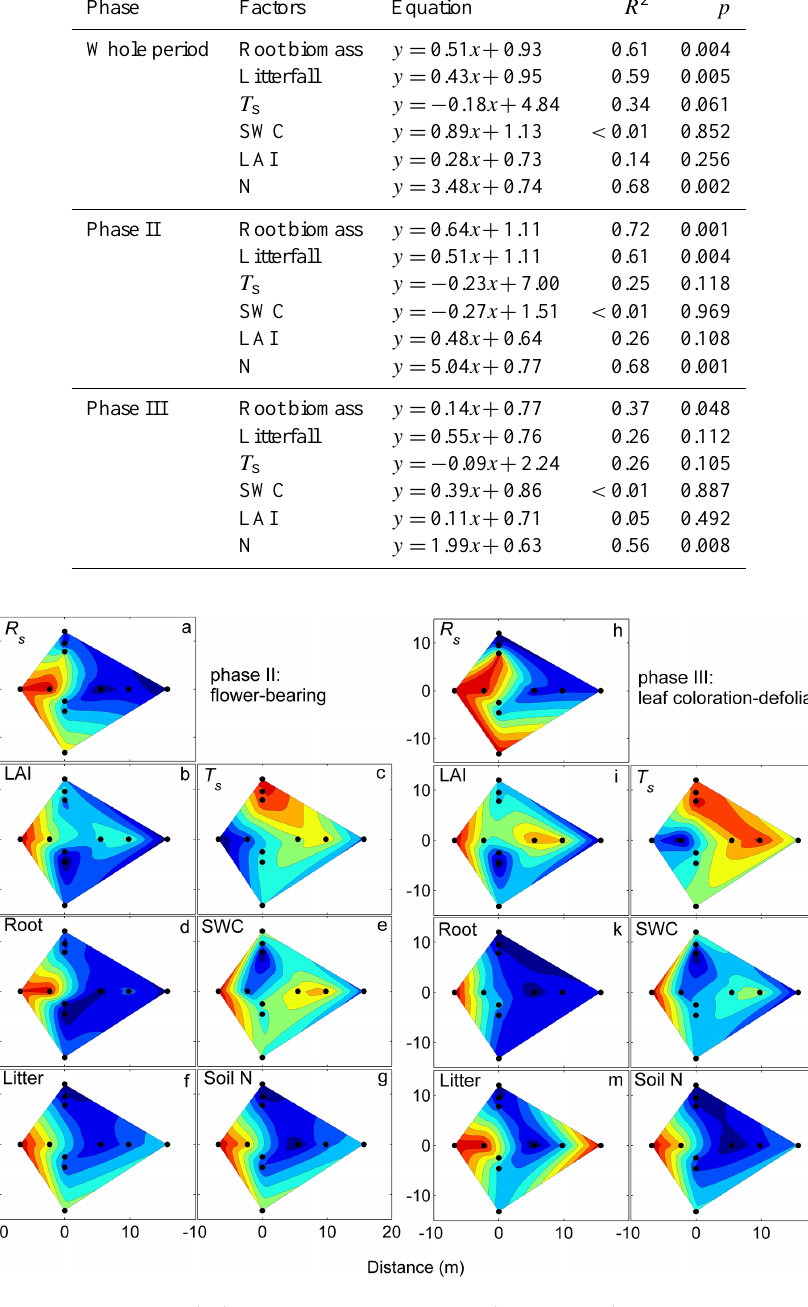
Figure 6. Spatial patterns of soil respiration ( R s ), microhydrometeorological ( T s and SWC) and plant-related factors (Litter, Root, Soil N and LAI) over the sand dune in flower-bearing phase (phase II) and coloration–defoliation phase (phase III). Data values for all variables were normalized into the range of 0–1 using feature scaling method ( X normalized = ( X − X min ) / ( X max − X min ) ). Black dots represent the measurement positions as shown in Fig.